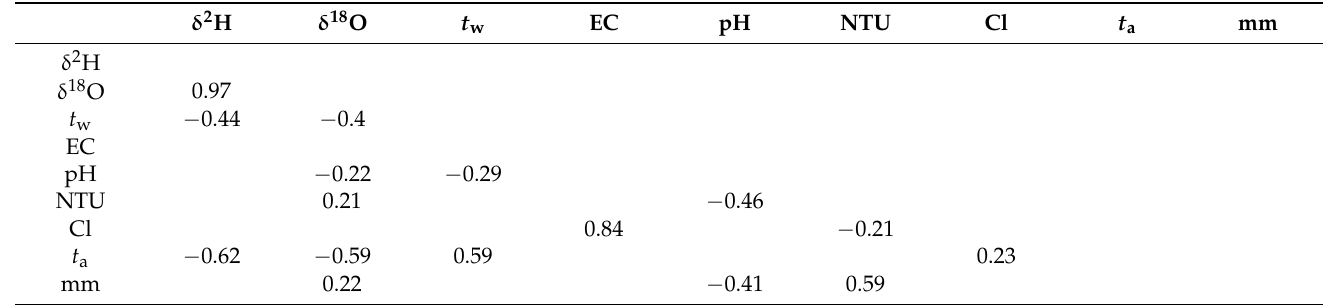
Table 6. Matrix of linear correlation coefficients between groundwater parameters of Dobrica spring (DBC). Only statistically significant coefficients are given. t w —water temperature, EC—electrical conductivity, NTU—turbidity; Cl—chloride ion concentration; t a —average air temperature between two consecutive samplings; mm—total rainfall between two consecutive